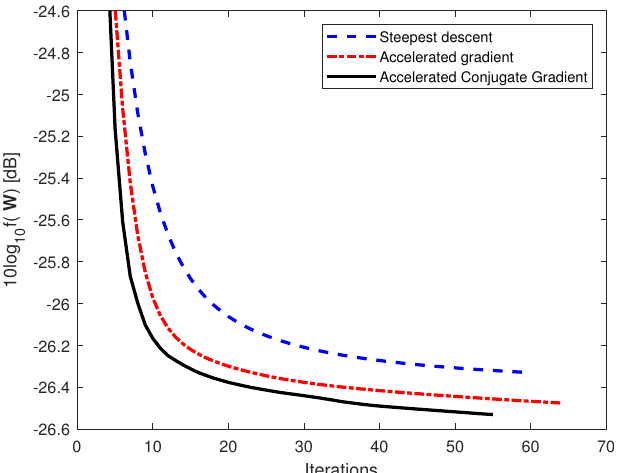
Figure 4. Convergence for real car recording data with three microphones and 0dB SNR.